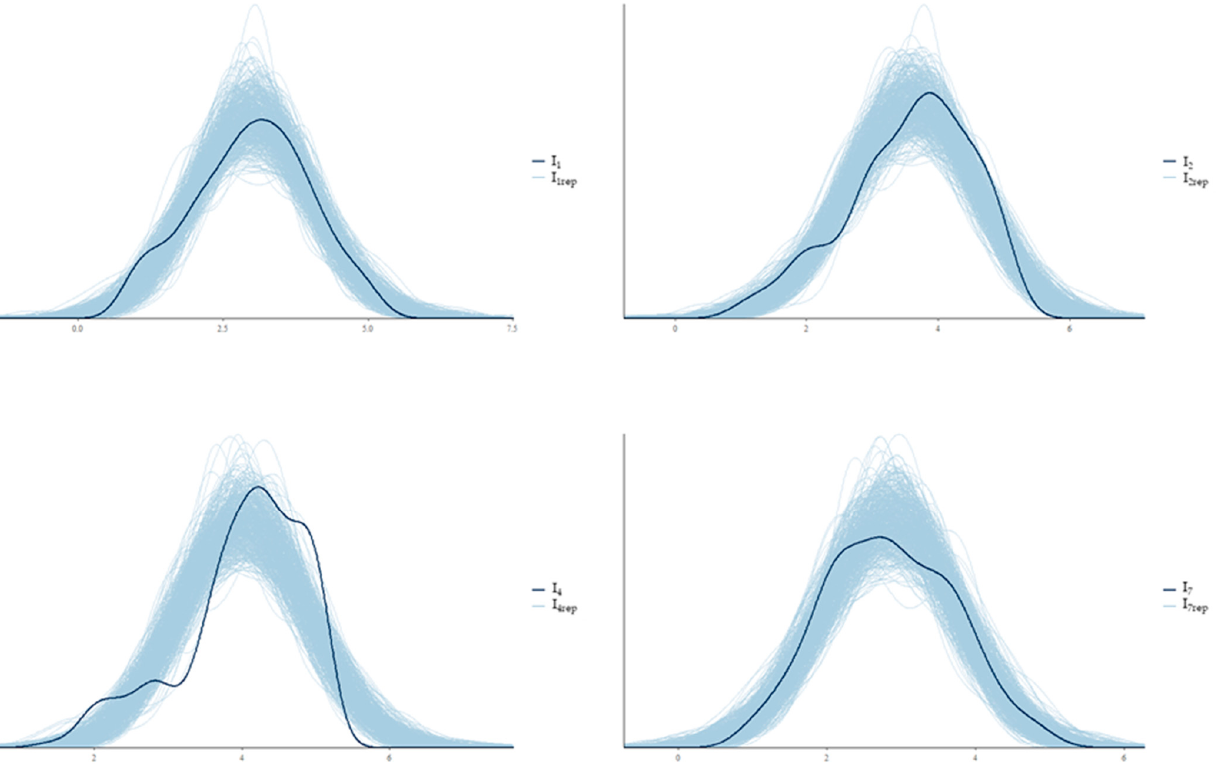
Figure 3. Posterior predictive check by densities overlay.